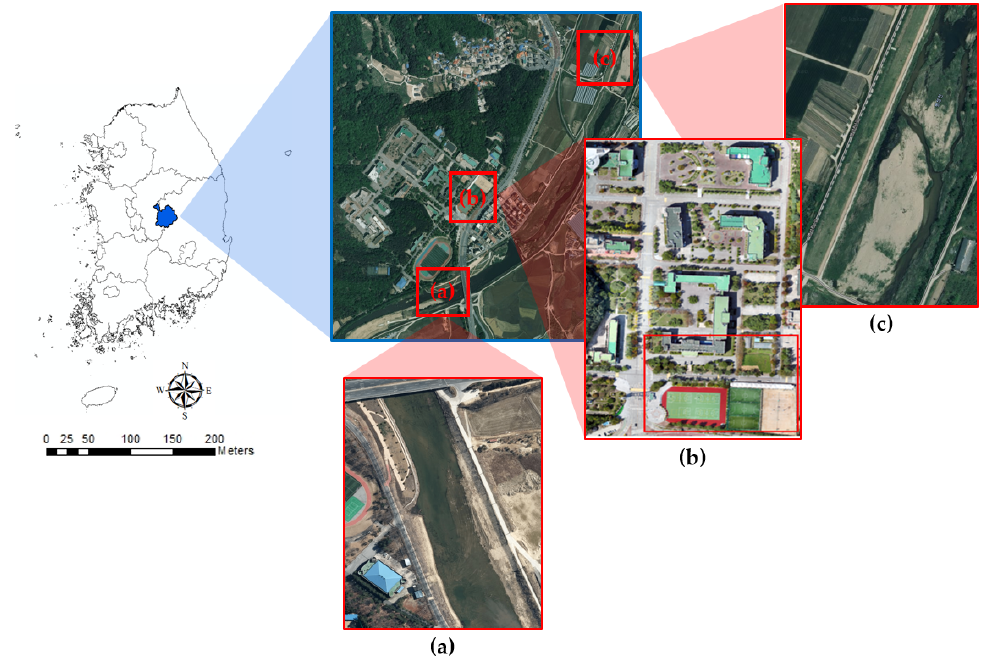
Figure 2. Study area: ( a ) plants, trees and river, ( b ) Kyungpook National University Sangju Campus, ( c ) farmland and river.